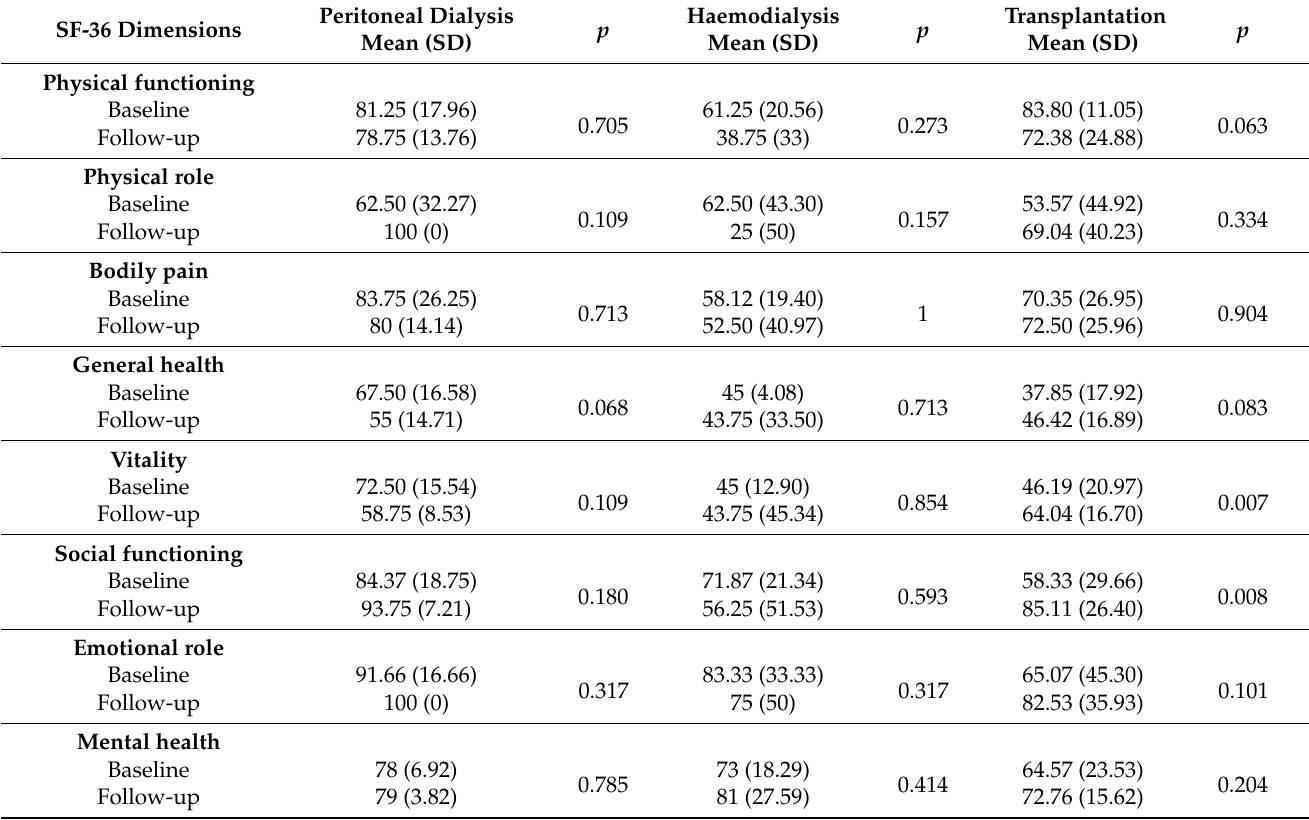
Table 3. Comparison of quality of life at baseline and follow-up by the type of renal replacement therapy